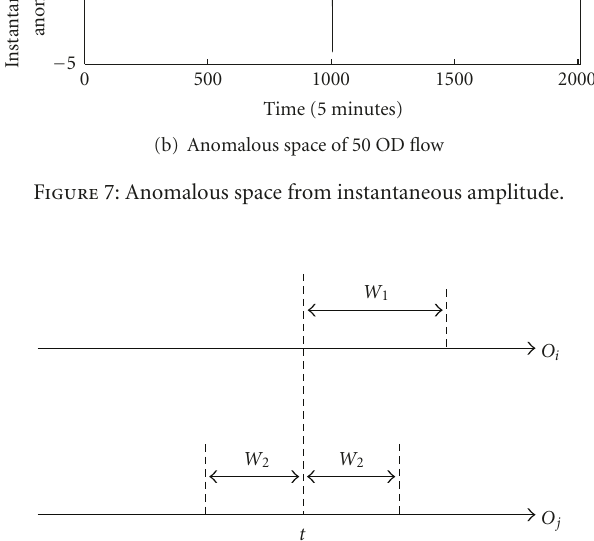
Figure 8: The correlation coe ffi cient computation of two anoma- lous